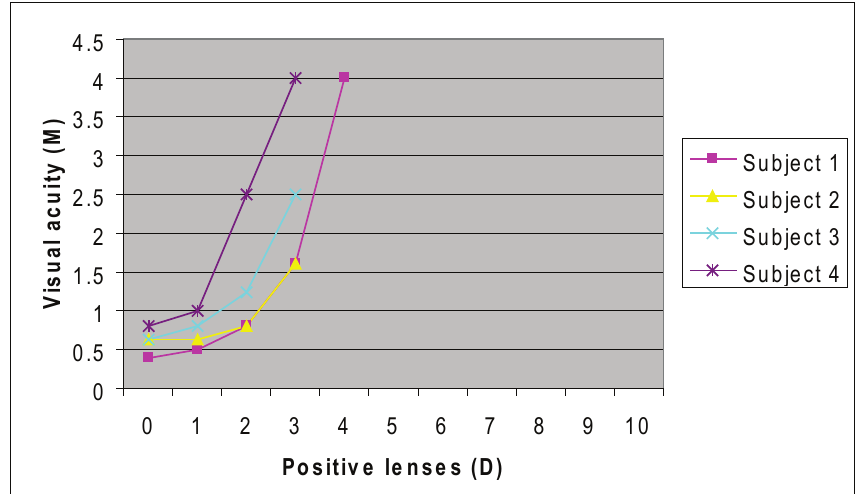
Figure 5. Effect of positive lenses on visual acuity viewing a near acuity chart at 0.4 m through a pinhole with a 1.5 mm diameter and illumination of 1 lux.